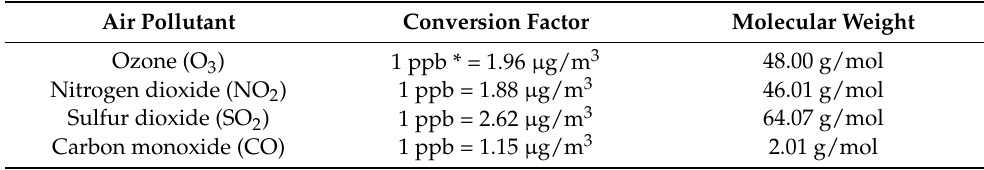
Table 2. Conversion factors and molecular weights for the air pollutants at standard pressure and